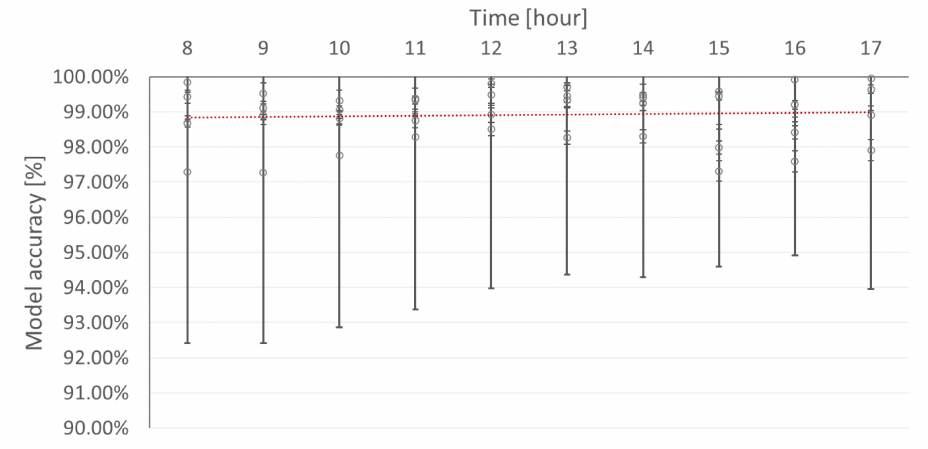
Figure 22. Accuracy of the simulation model at 5%